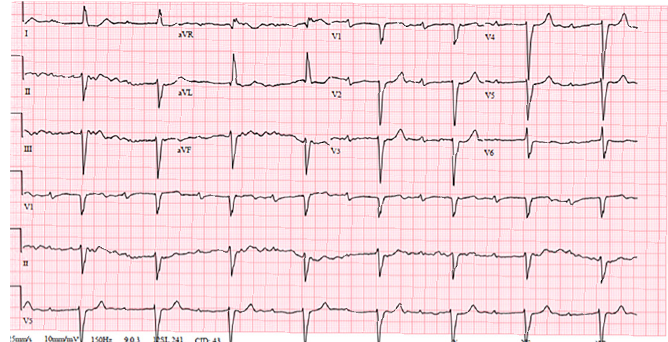
Image 1. Electrocardiogram of a 55-year-old male with palpitations and dyspnea, taken while in the emergency department.